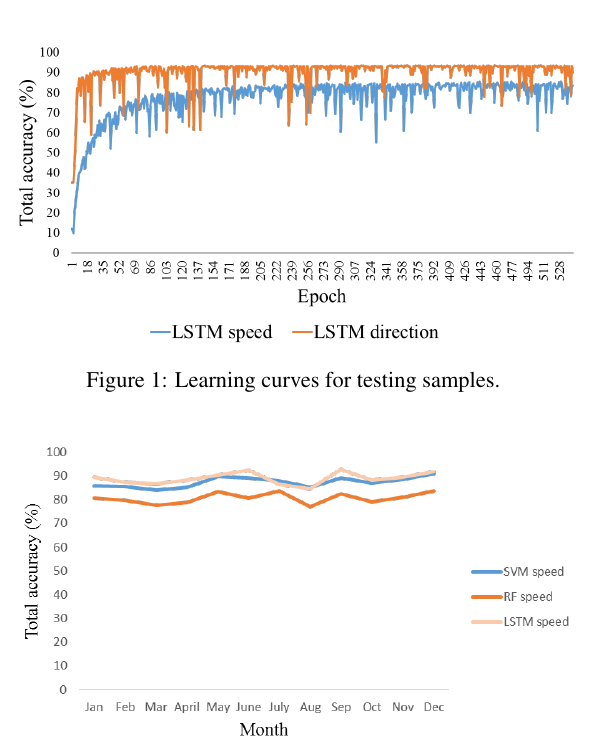
Figure 2: Total accuracy for different months for Stuttgart (in speed case).